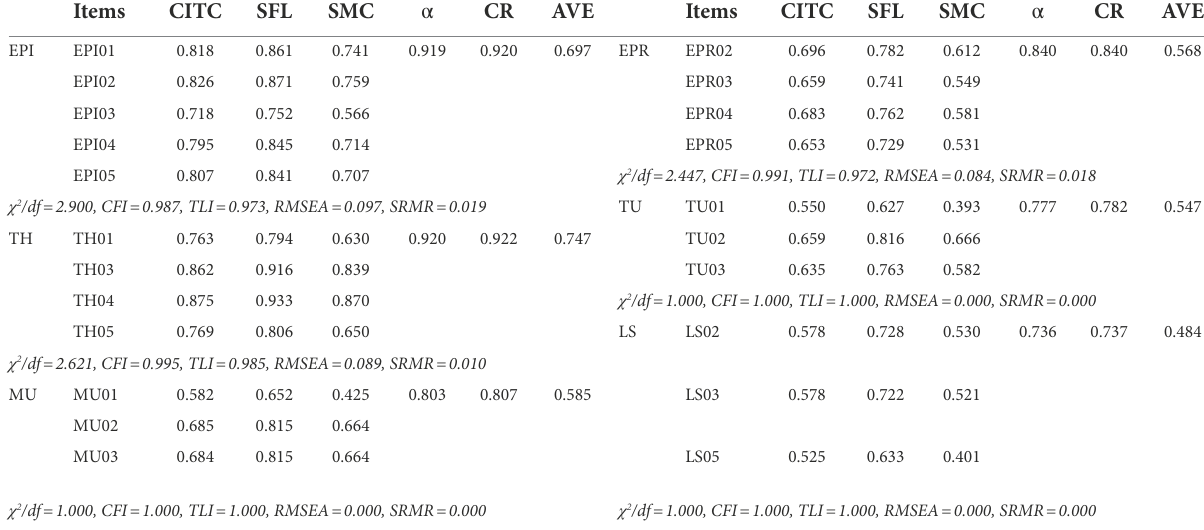
TABLE 2 Reliability and convergent validity test results ( N = 203).